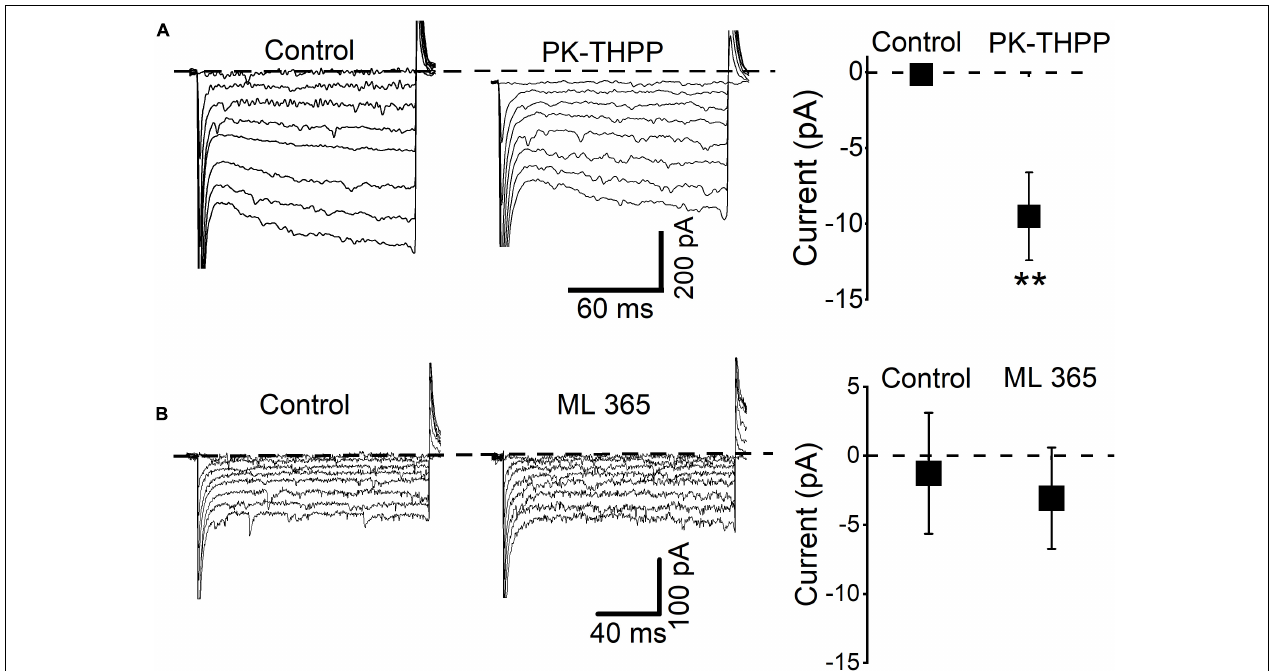
FIGURE 6 | DMV neurons express a leak K + conductance similar to TASK-3 neurons. (A) Current traces from hyperpolarizing voltage steps (increment: -10 mV, range: from -50 to -120 mV) applied in control conditions and during application of PK-THPP (0.1 µ M). Average baseline holding current recorded from cells in the control condition and during application of PK-THPP ** P < 0.01 ( n = 5). (B) Current traces from hyperpolarizing voltage steps applied in control conditions and during application of ML365 (10 nM). Dashed lines indicate current level at -50